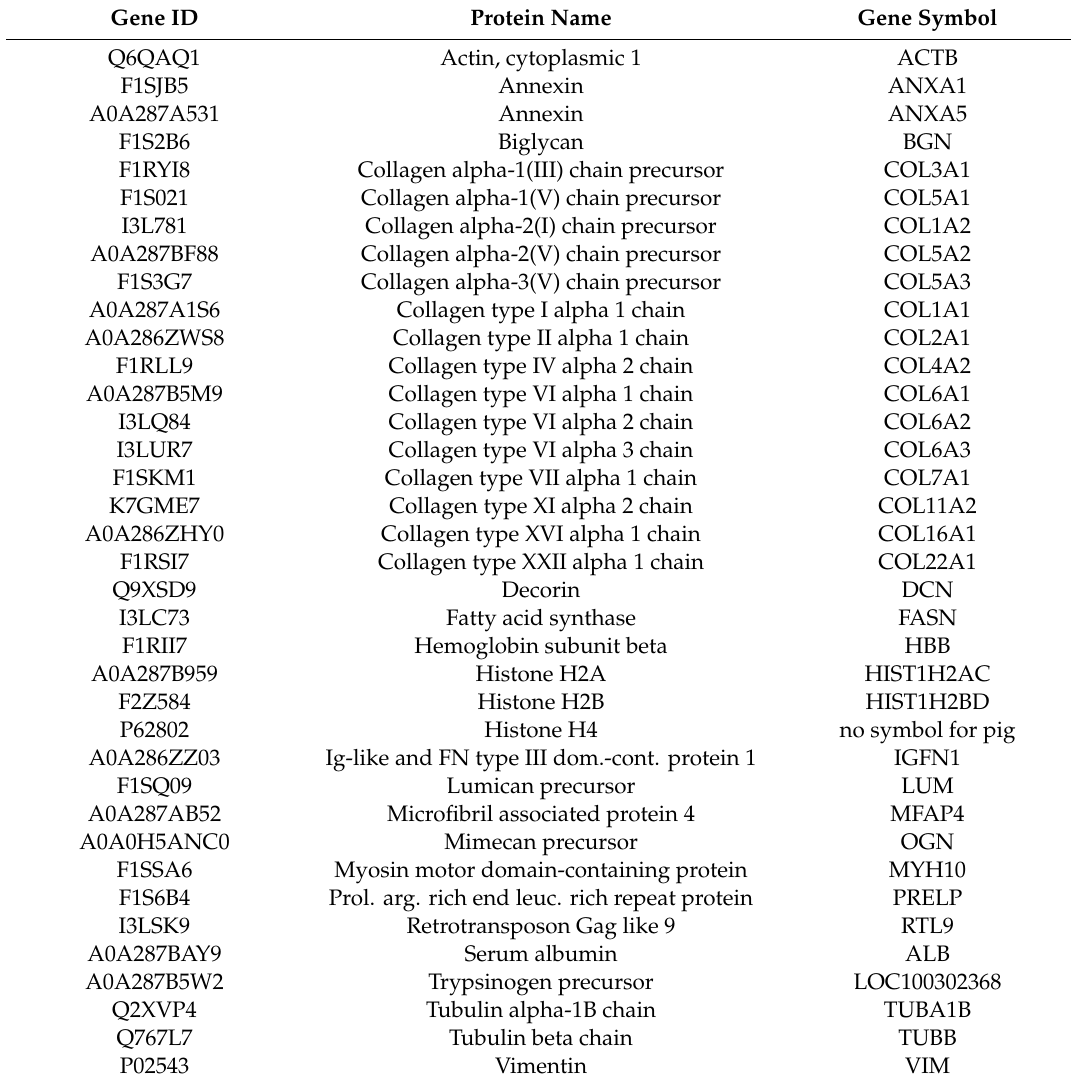
Table 1. The 37 proteins identified in all lots of collagen membranes and